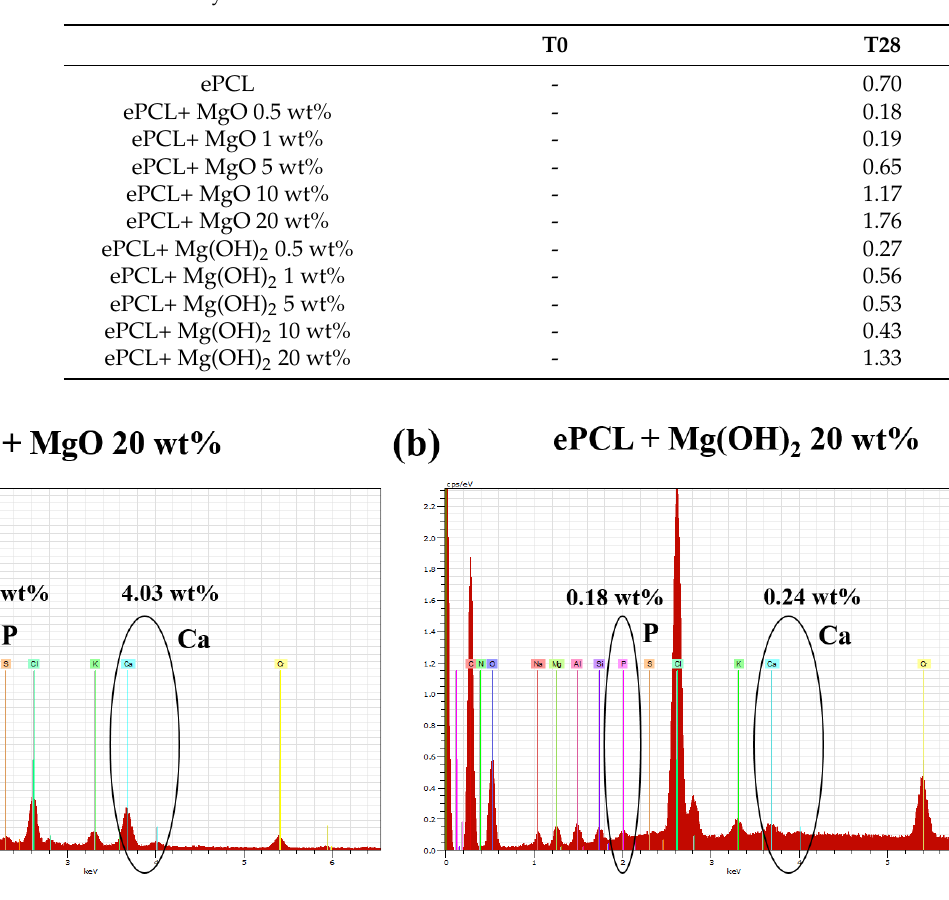
Table 2. Calculated Ca/P ratio values of ePCL, ePCL + MgO NPs and ePCL + Mg(OH) 2 NPs at T0 and after 28 days of immersion in SBF.